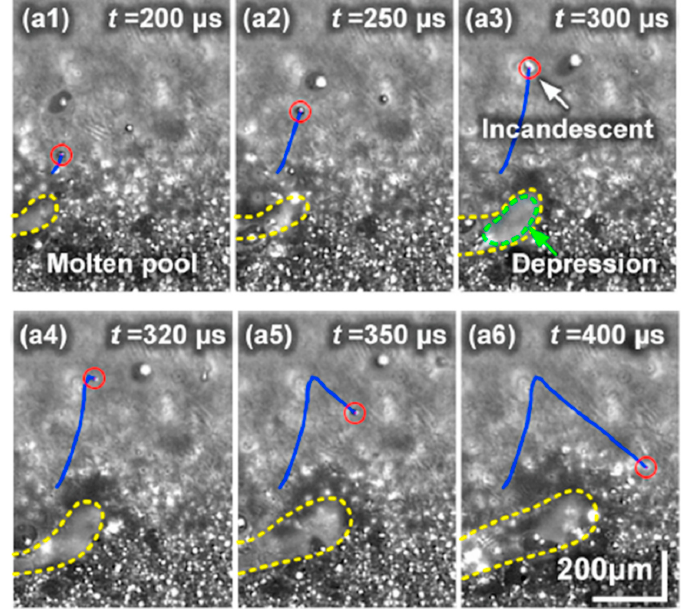
Figure 6. Snapshots of high-speed camera of the forward-ejected spatters, from t = 200 µs to t = 400 µs (from left to right) at a laser power of 1150 W (Inconel 718 powder). Adapted from Reference [132] with permission from Elsevier.